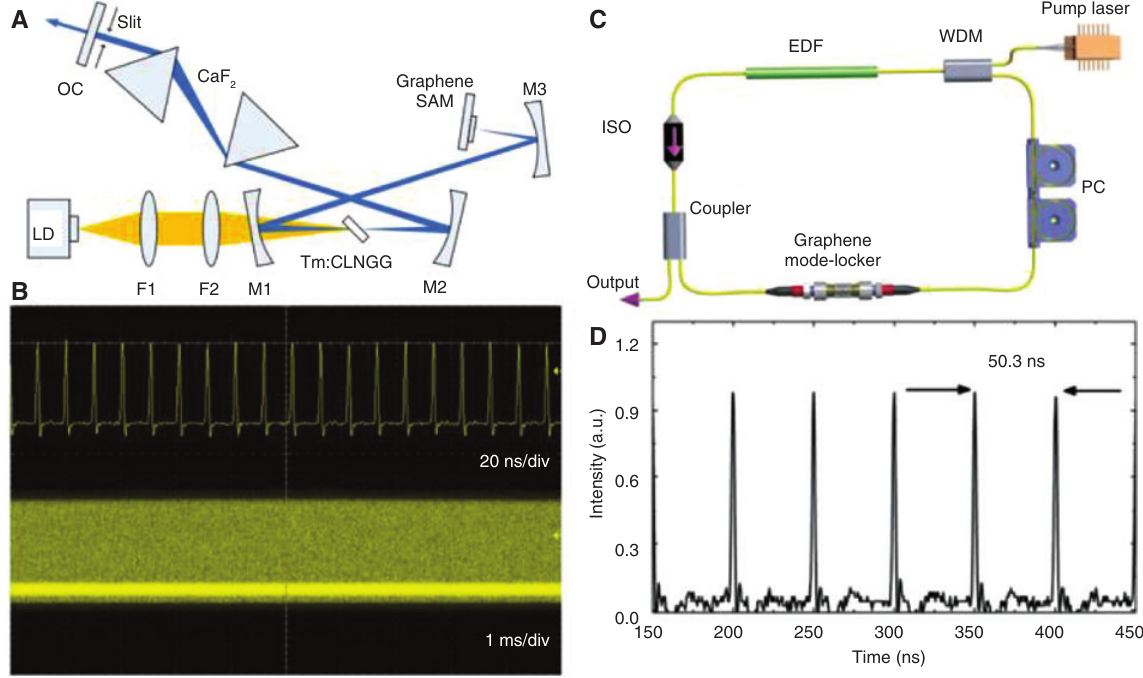
Figure 6: 2D material based mode-locking. (A) Experimental setup of the mode-locked laser based on the graphene saturable absorption mirror; (B) CW mode-locked pulse trains in nanosecond and millisecond time scales; (C) graphene mode-locked fiber laser where the mode-locker assembly contains a graphene flake. (D) Auto-correlation trace of output pulses showing the pulse repetition rate of 19 MHz. Figures (A) and (B) are reprinted from Ref. [88]. Figures (C) and (D) are reprinted with permission from Ref. [89]. Copyright (2010) American Chemical Society.